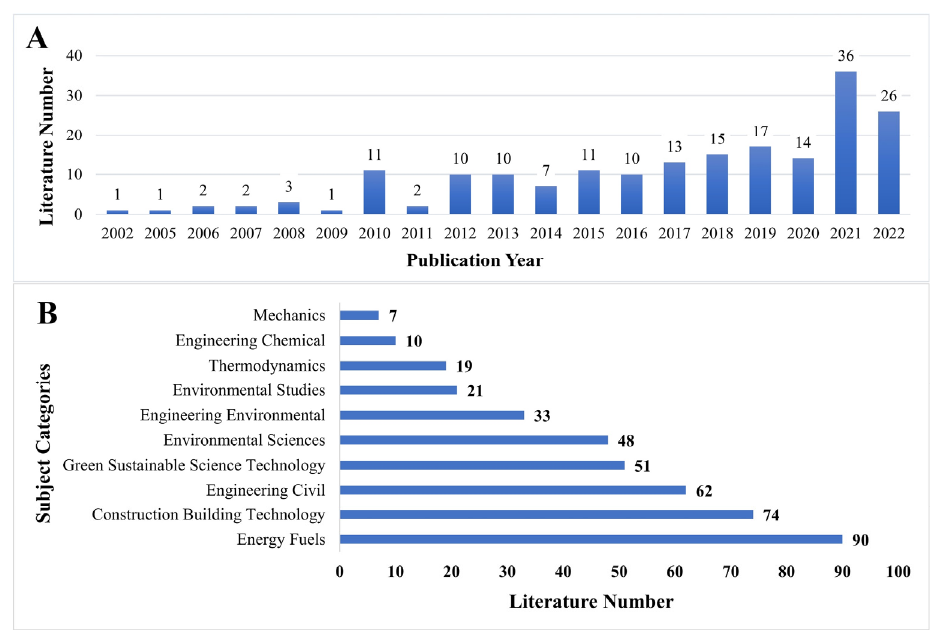
Figure 2. ( A ) The distribution of the annual volume of publications on the CEPB from 2002 to 2022, ( B ) Top ten subject categories of the Web of Science for CEPB from 2002 to 2022.